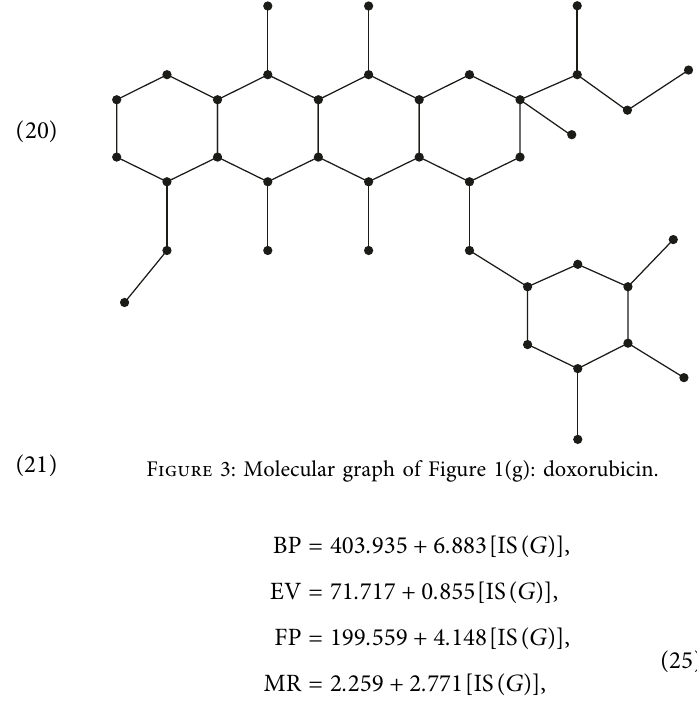
Figure 3: Molecular graph of Figure 1(g):